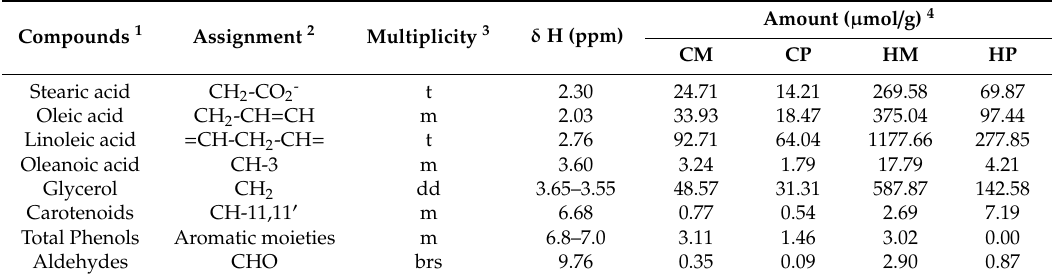
Table 1. 1 H-NMR quantitative analyses of extracts.